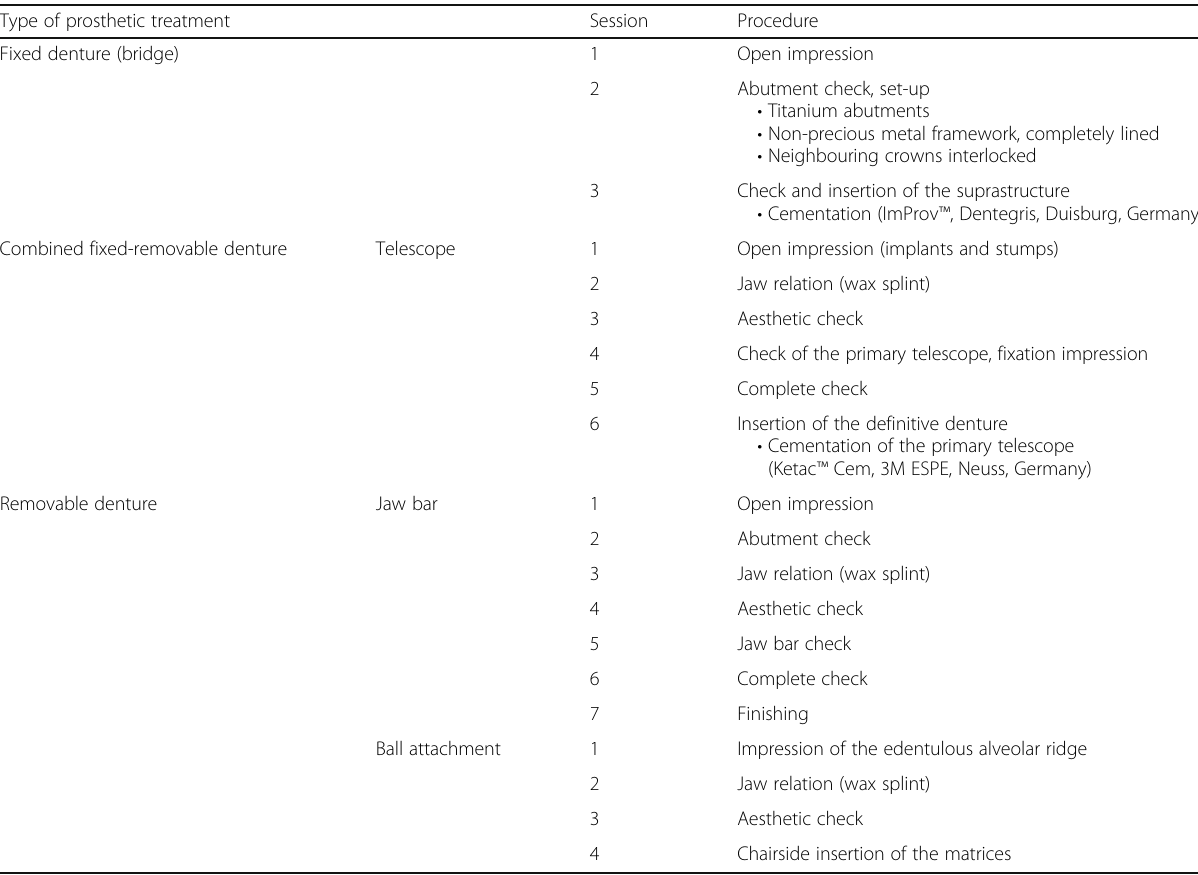
Table 3 Prosthetic treatment protocol Type of prosthetic